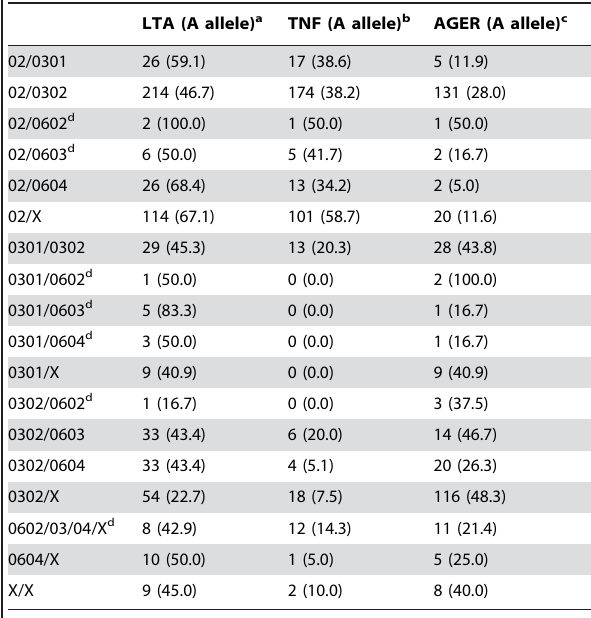
Table 3. Minor allele frequencies according to HLA-DQB1 genotype in type 1 diabetic